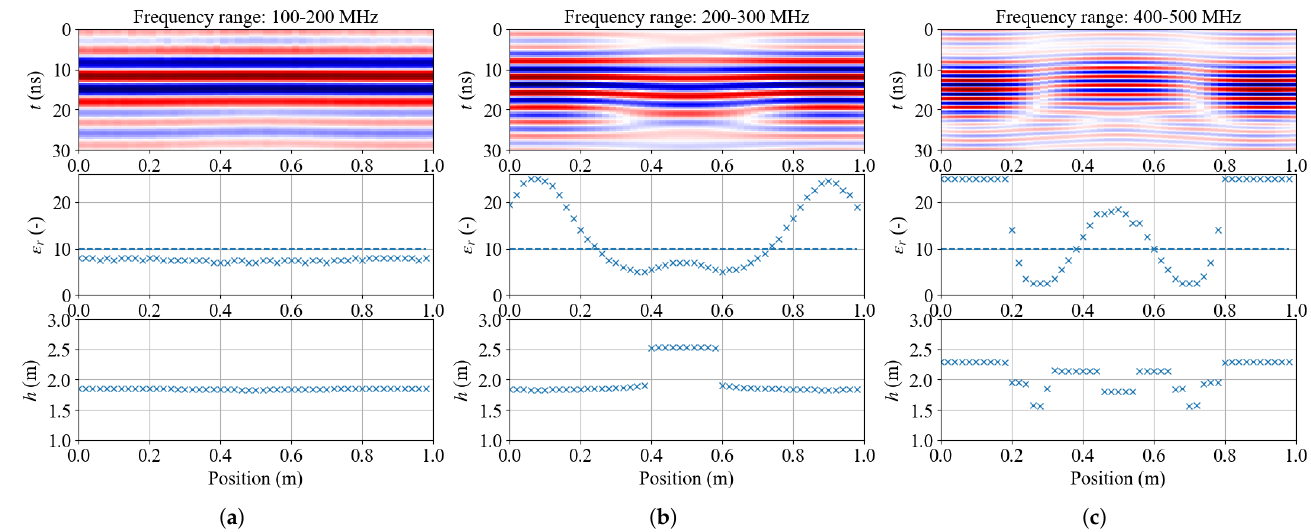
Figure 2. FDTD Green’s functions and inversion results with centre frequency ( a ) 150 MHz, ( b ) 250 MHz, and ( c ) 450 MHz. True ε r = 10, h min = 1.78 m, and h max = 2.00